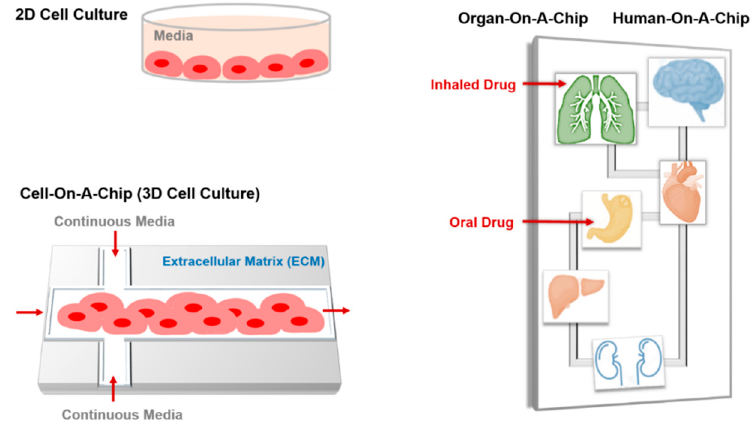
Figure 7. Schematic drawing of 2D cell culture, cell ‐ , organ ‐ , and human ‐ on ‐ a ‐ chip.